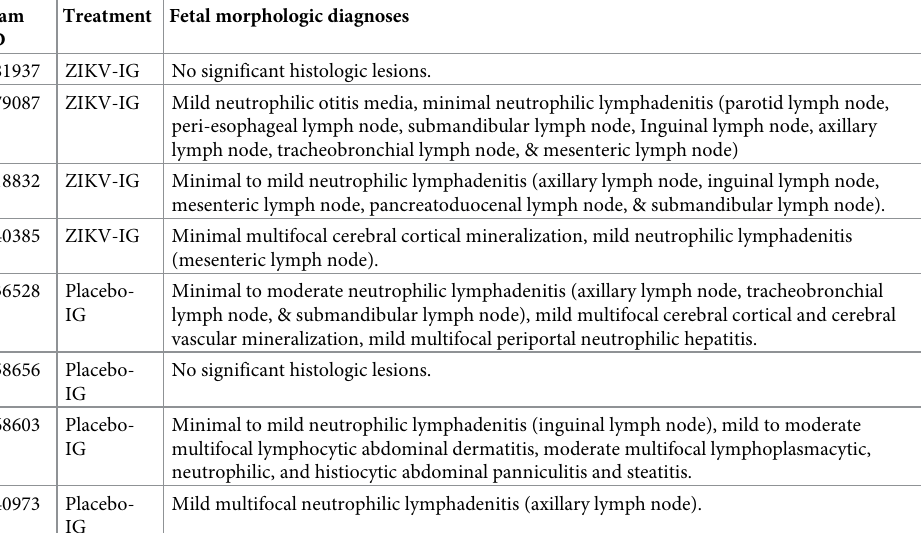
Table 2. Fetal pathology-morphologic